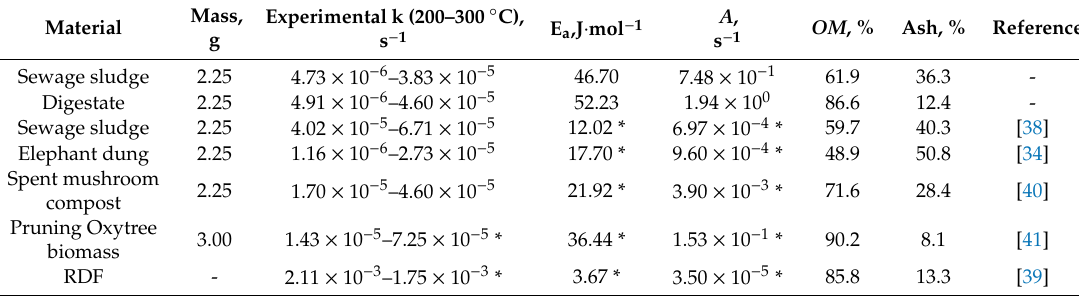
Table 4. Summary of the torrefaction kinetic parameters for di ff erent